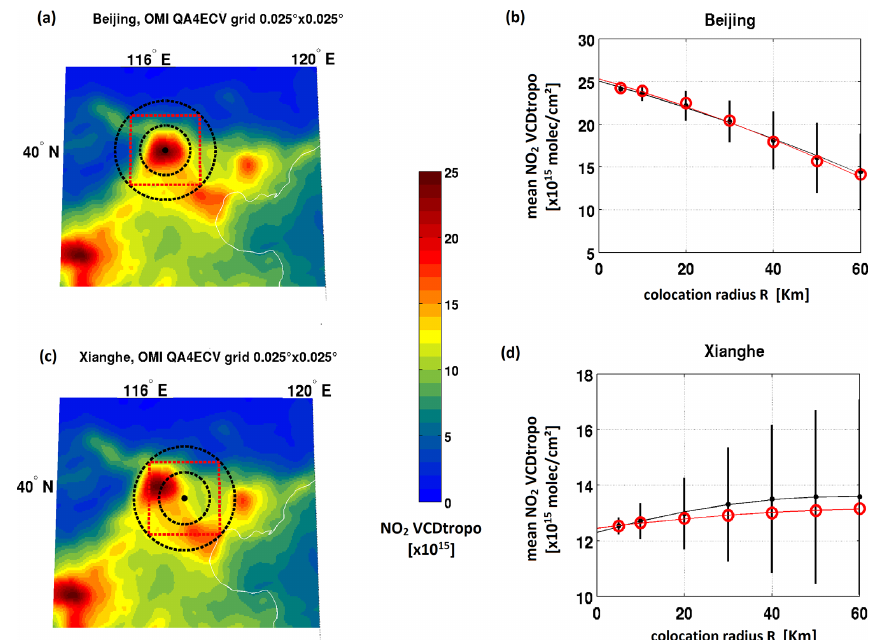
Figure 9. Dilution effect illustration for a typical urban (Beijing, a , b ) and suburban (Xianghe, c , d ) case. Panels (a, c) represent the 2005 yearly mean tropospheric NO 2 gridded from OMI QA4ECV data at the resolution of 0.025 ◦ latitude × 0.025 ◦ longitude. The black dot indicates the station location, the two circles denote 50 and 100km radii around the station and the red box represents the outer extent of any 80km × 40km GOME-2A pixels whose centers are within the 50km radius. Panels (b, d) display the mean (black) and median (red) NO 2 values at increasing colocation radii (expressed in kilometers), with the variability (1 standard deviation) given as an error bar around the